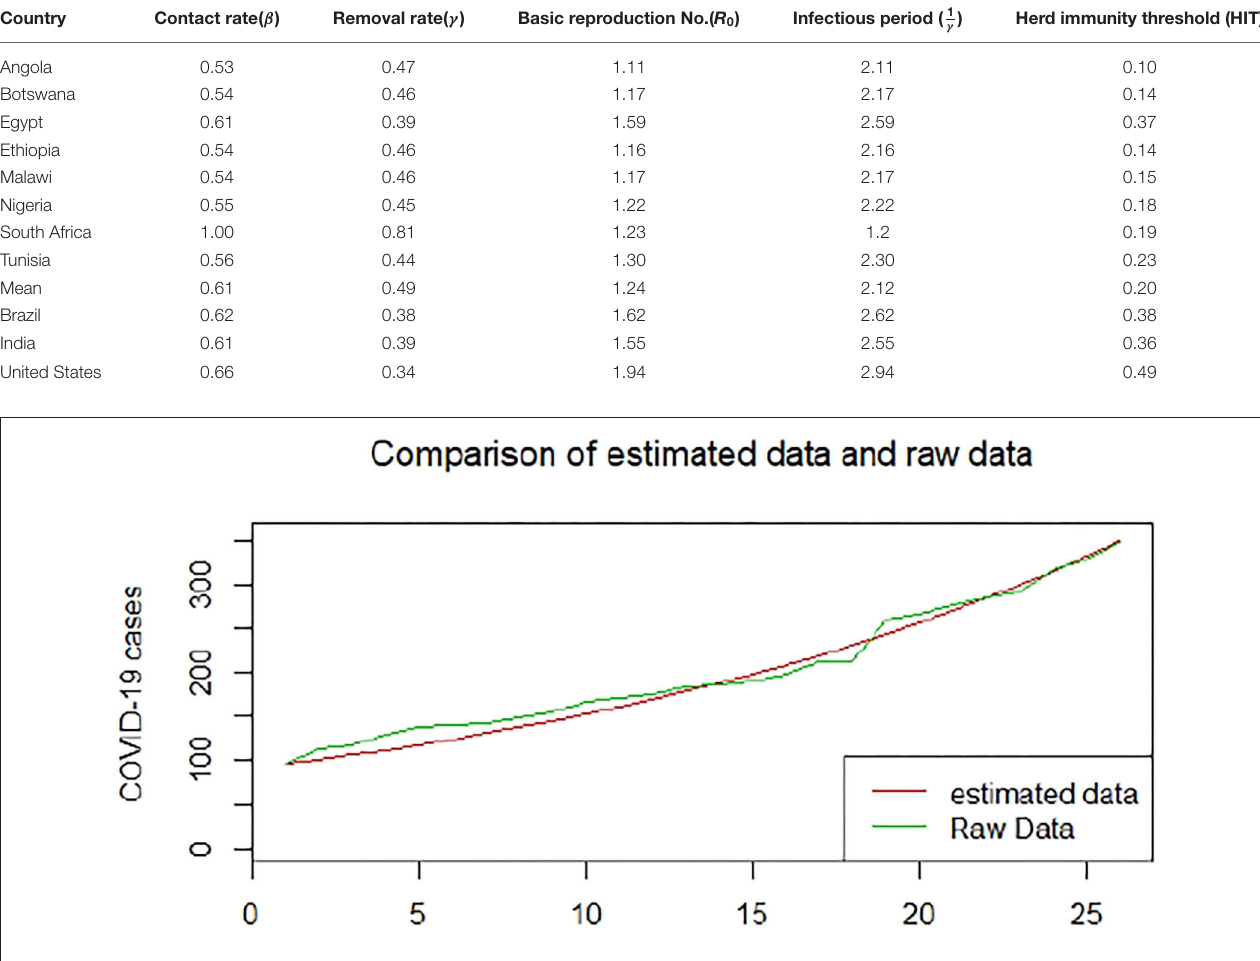
TABLE 2 | COVID-19 contagiousness and impact in the 8 countries. Country Contact rate( β ) Removal rate( γ ) Basic reproduction No.( R 0 ) Infectious period ( 1